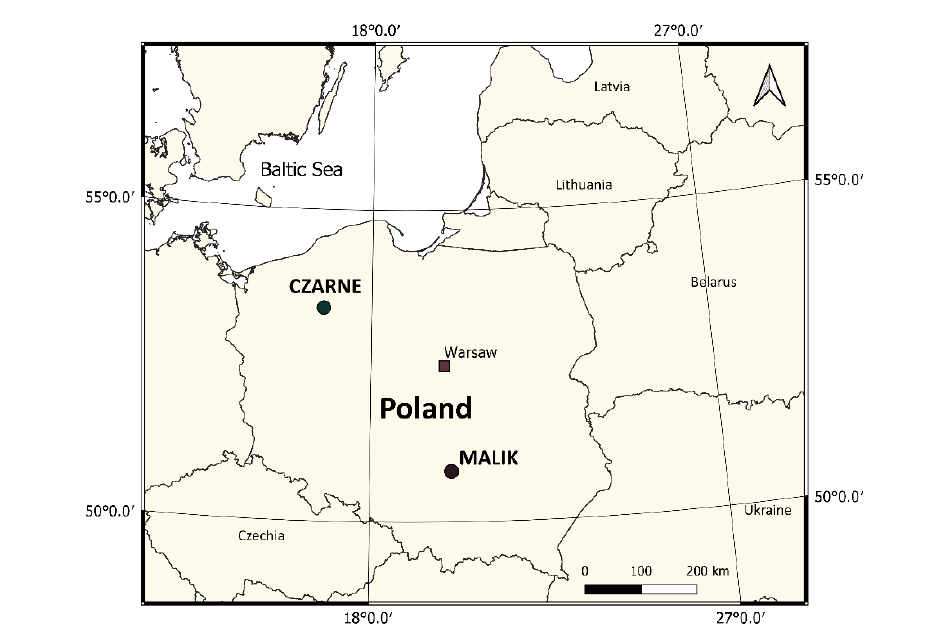
Figure 1. Location of the sampling site. Table 1. Characteristics of the experimental stands.